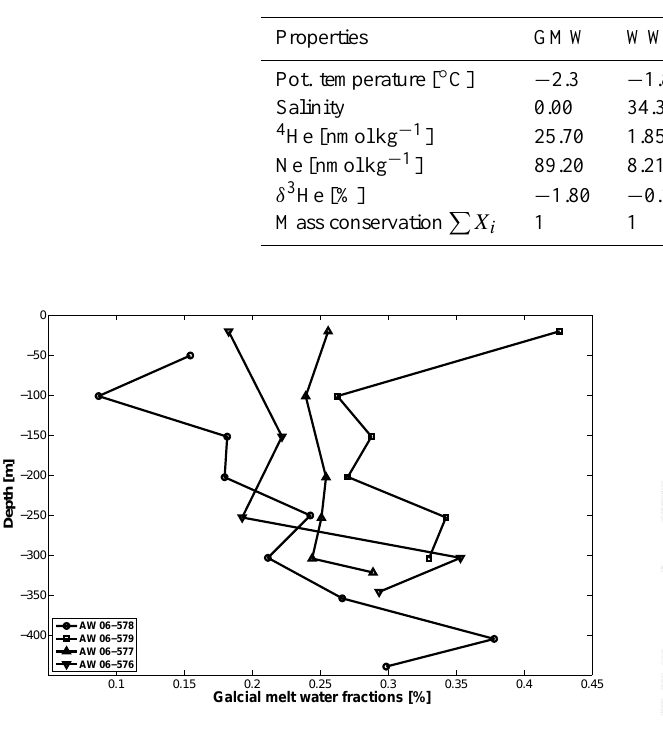
Fig. 5. Depth profiles of glacial melt water fraction [%] for the four southernmost AW 06 (WWOS) stations on the western Weddell Sea continental shelf (black square in Fig. 2). The GMW fraction mean is 0.25% with a standard deviation of 0.07%. The surface sam- ple at station AW 06-579 might be an outlier, because He and Ne samples both are comparably too high for surface water, which in- dicates contamination by air. To compensate for the high values, OMP would overestimate the GMW value. Fig. 6. Austral summer θ /S–characteristics (gray) on the shallow ( < 500 m) northwestern Weddell Sea conti- nental shelf for cruises AS 06 and AS 09 (red dots in Fig. 1a). Colored dots depict certain stations (see insert) representing the two different ’thermal’ regimes on the continental shelf. The lower line represents the surface freezing temperature as a function of salinity. Isopycnals are drawn relative to surface pressure ( σ 0 ).